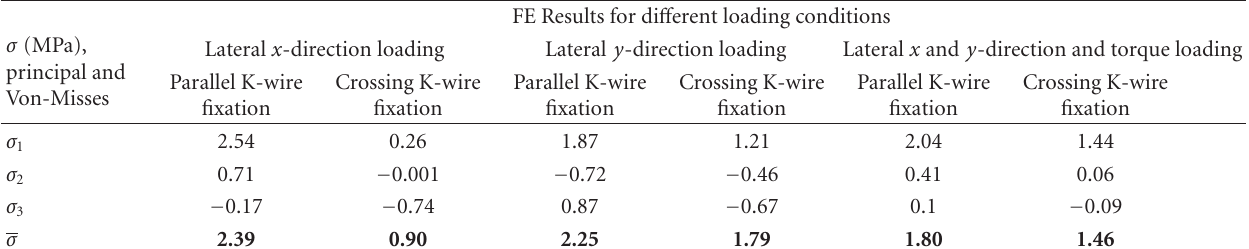
Table 3: Summary of FE results for top crack area.